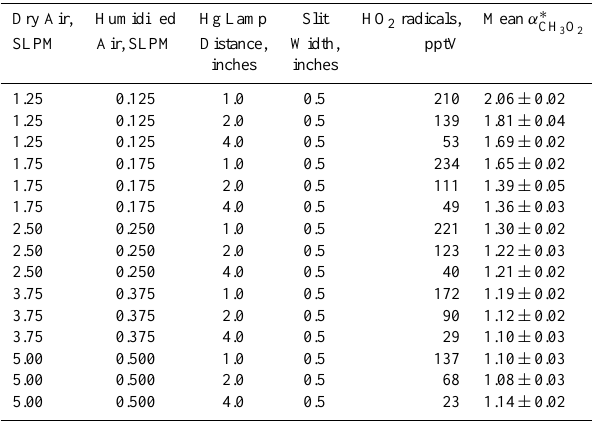
Table 3. Summary of dependence on the total flow of humidified air through the calibration cell.